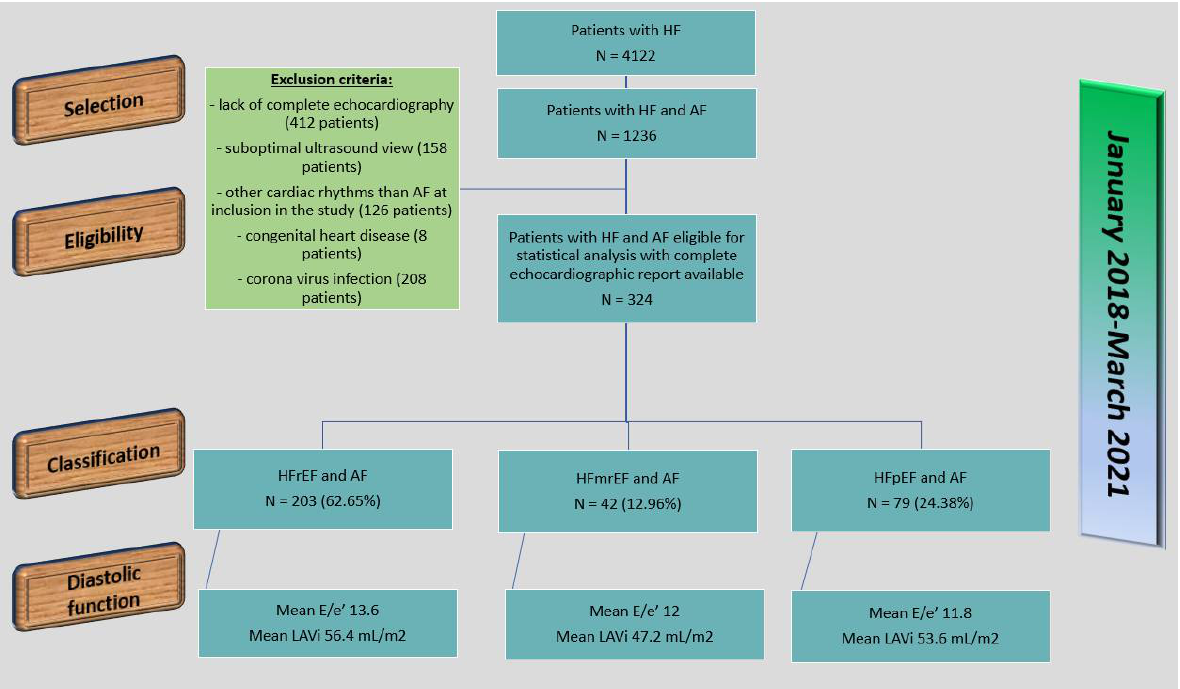
Figure 1. Protocol of the study. Legend : HF—heart failure; AF—atrial fibrillation; HFrEF—heart failure with reduced ejection fraction; HFmrEF—heart failure with mildly reduced ejection fraction; HFpEF—heart failure with preserved ejection fraction; LAVi—left atrial volume index. Baseline demographics were obtained at inclusion in the study. The following data were collected: general data (sex, age), medical history, comorbidities, current